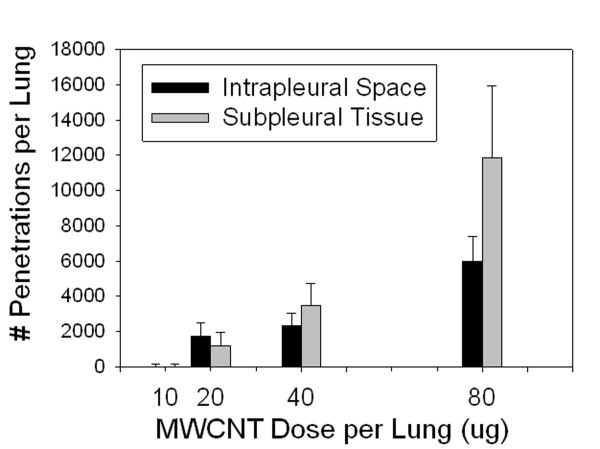
Effect of MWCNT dose on MWCNT fiber penetrations into subpleural tissue and intrapleural space 56 days after aspiration. This figure shows the number per lung for fibers which penetrated into the subpleural tissue and for fibers which penetrated into the intrapleural space. As indicated by the asterisks, both the number of subpleural tissue and intrapleural space penetrations at 80 μg were different from the corresponding subpleural tissue and intrapleural space penetrations at doses of 10, 20 and 40 μg. (Mean ± SE, N = 8).